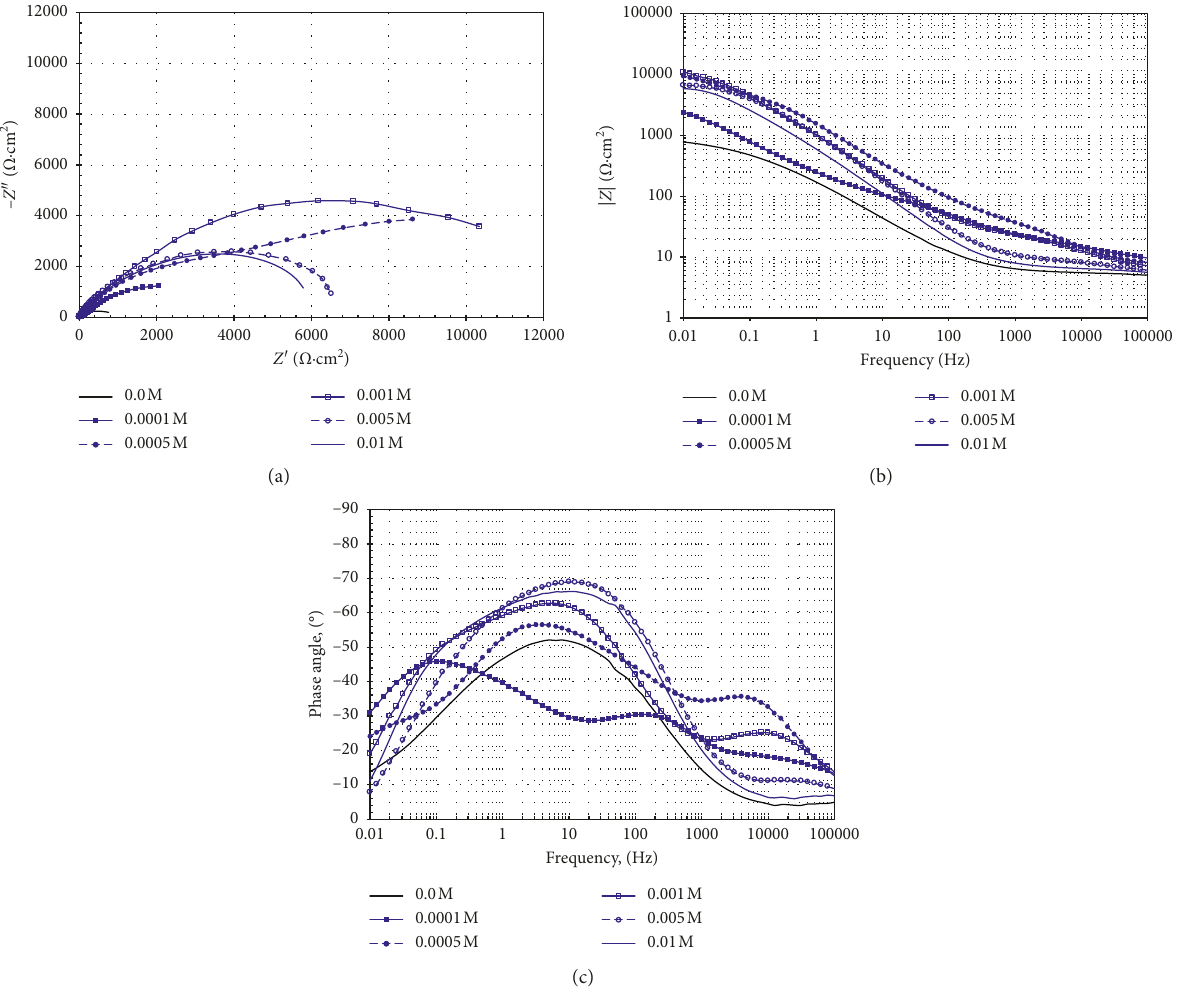
Figure 12: Nyquist and Bode diagrams for API X70 steel with and without the addition of the inhibitor synthesized from permanent magnets at different concentrations after 100 hours immersion in 3.5% NaCl solution at room